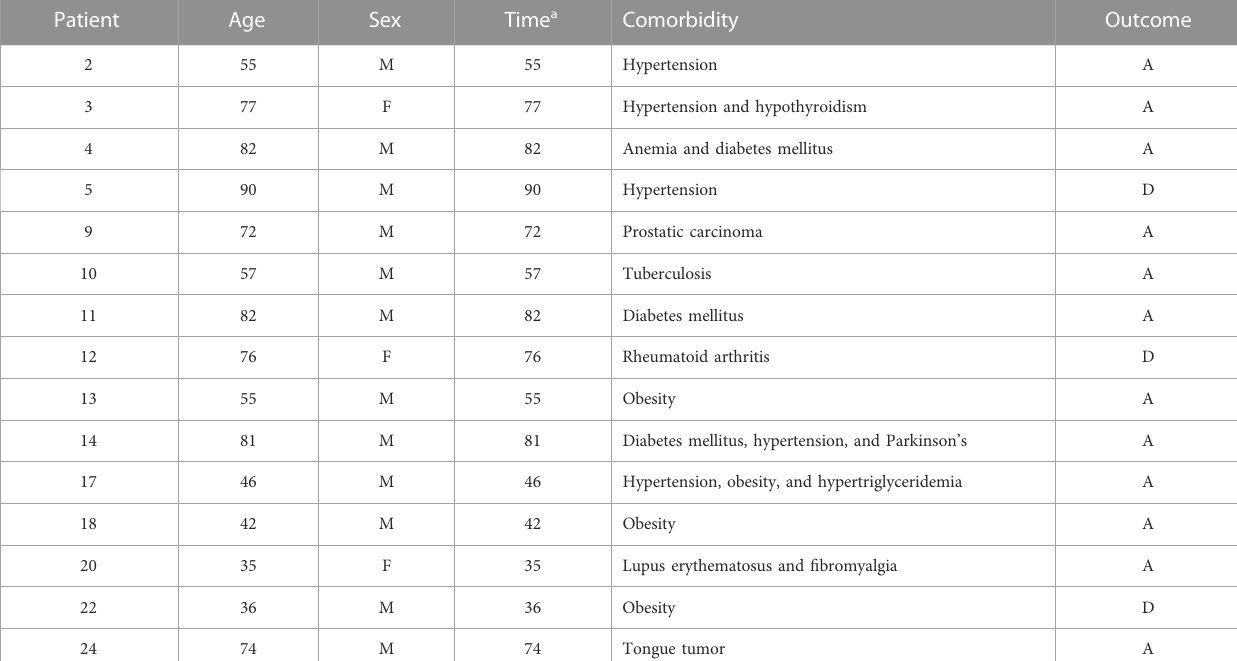
TABLE 3 Patients with comorbidities.